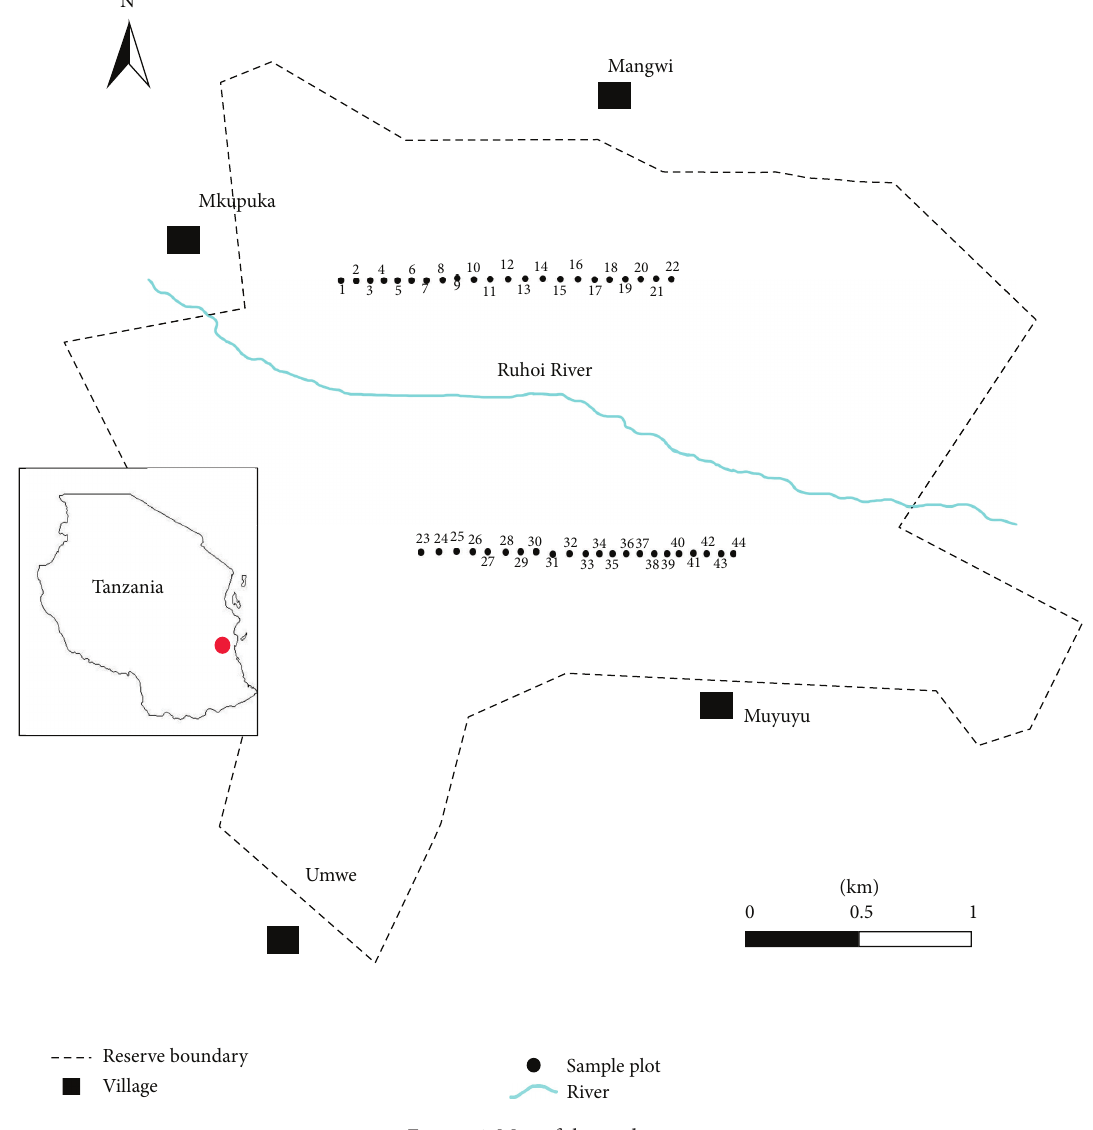
Figure 1: Map of the study